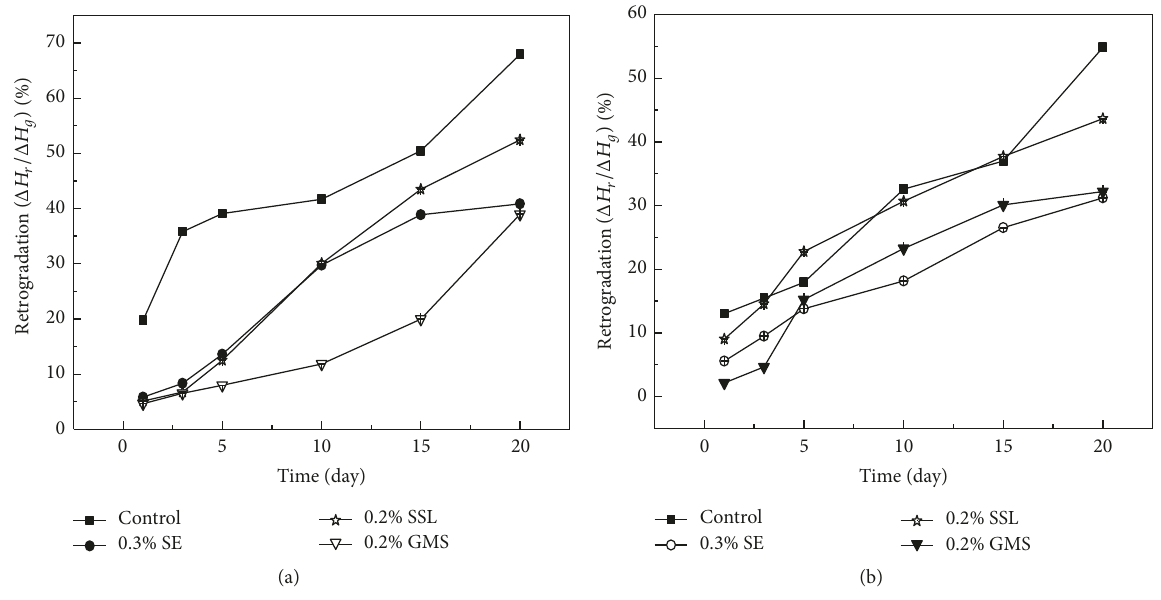
Figure 1: Retrogradation index ( Δ𝐻 𝑟 / Δ𝐻 𝑔 ) of rice gels with different days of storage at 4 ∘ C (a) and − 20 ∘ C (b). Error bars indicate standard